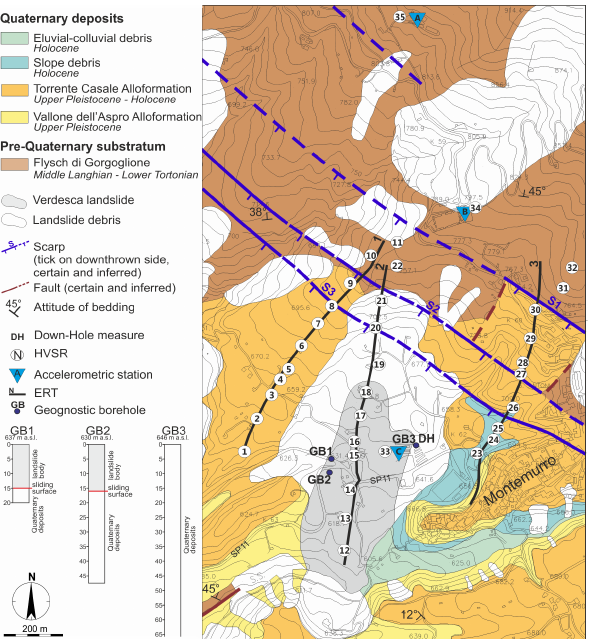
Figure 2. Simplified geological map of the study area showing the distribution of the NW–SE scarps observed in the field, the Verdesca landslide, the location of the surveys and the three simplified bore- hole